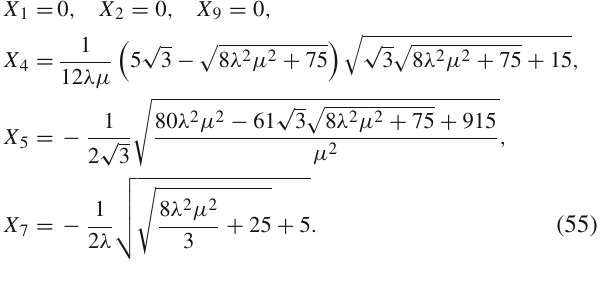
( B ) system are very 2